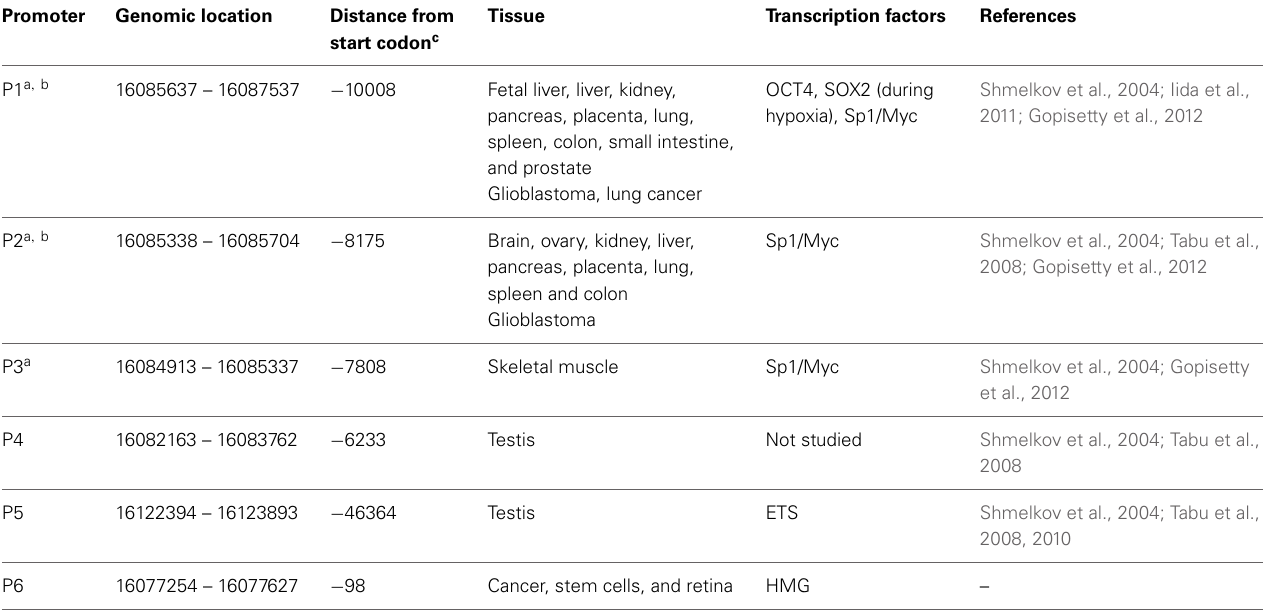
FIGURE 1 | Summary of PROM1 promoter architecture and cross-platform activity. Upper panel: CD133 promoter structure with known promoter regions P1–P5 (black rectangles), novel proximal promoter P6 (white rectangle), known exons A–E (gray rectangles), and CpG islands ( ∼ ). Lower panel: Promoter activity (colored rectangles, number of studies expressing that category) in normal tissues, cancer, Table 1 | PROM1 alternative promoters and